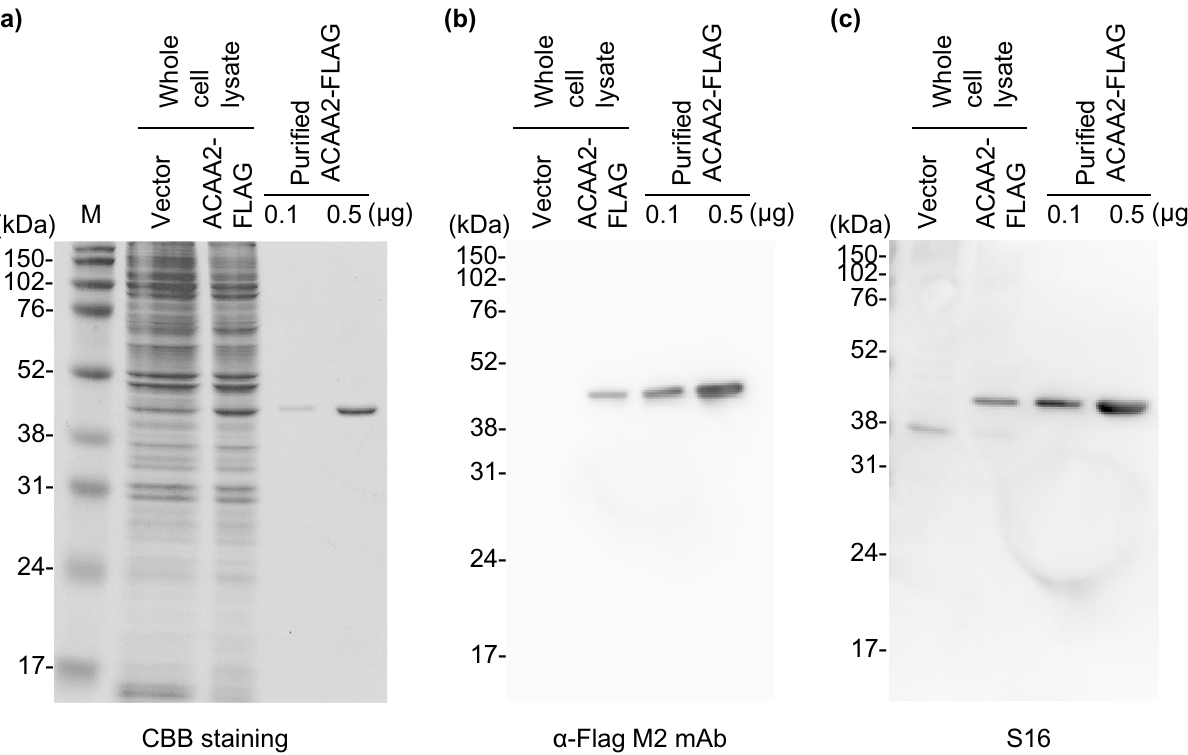
Figure 5. Binding of S16 with ACAA2. HEK293 cells were transfected with vector alone or ACAA2-FLAG expressing vector. The ACAA2-FLAG expressed in the cells was purified. The whole cell lysate (2 μg) transfected with vector alone (Vector), ACAA2-FLAG, and purified ACAA2-Flag (0.1 and 0.5 μg) were separated using 12% SDS-PAGE. The gel was subjected to CBB staining ( a ) and western blotting using α-Flag M2 mAb ( b ) or S16 ( c ). Molecular weight markers are shown at the left of the gels (kDa). The images shown are representative results of three independent